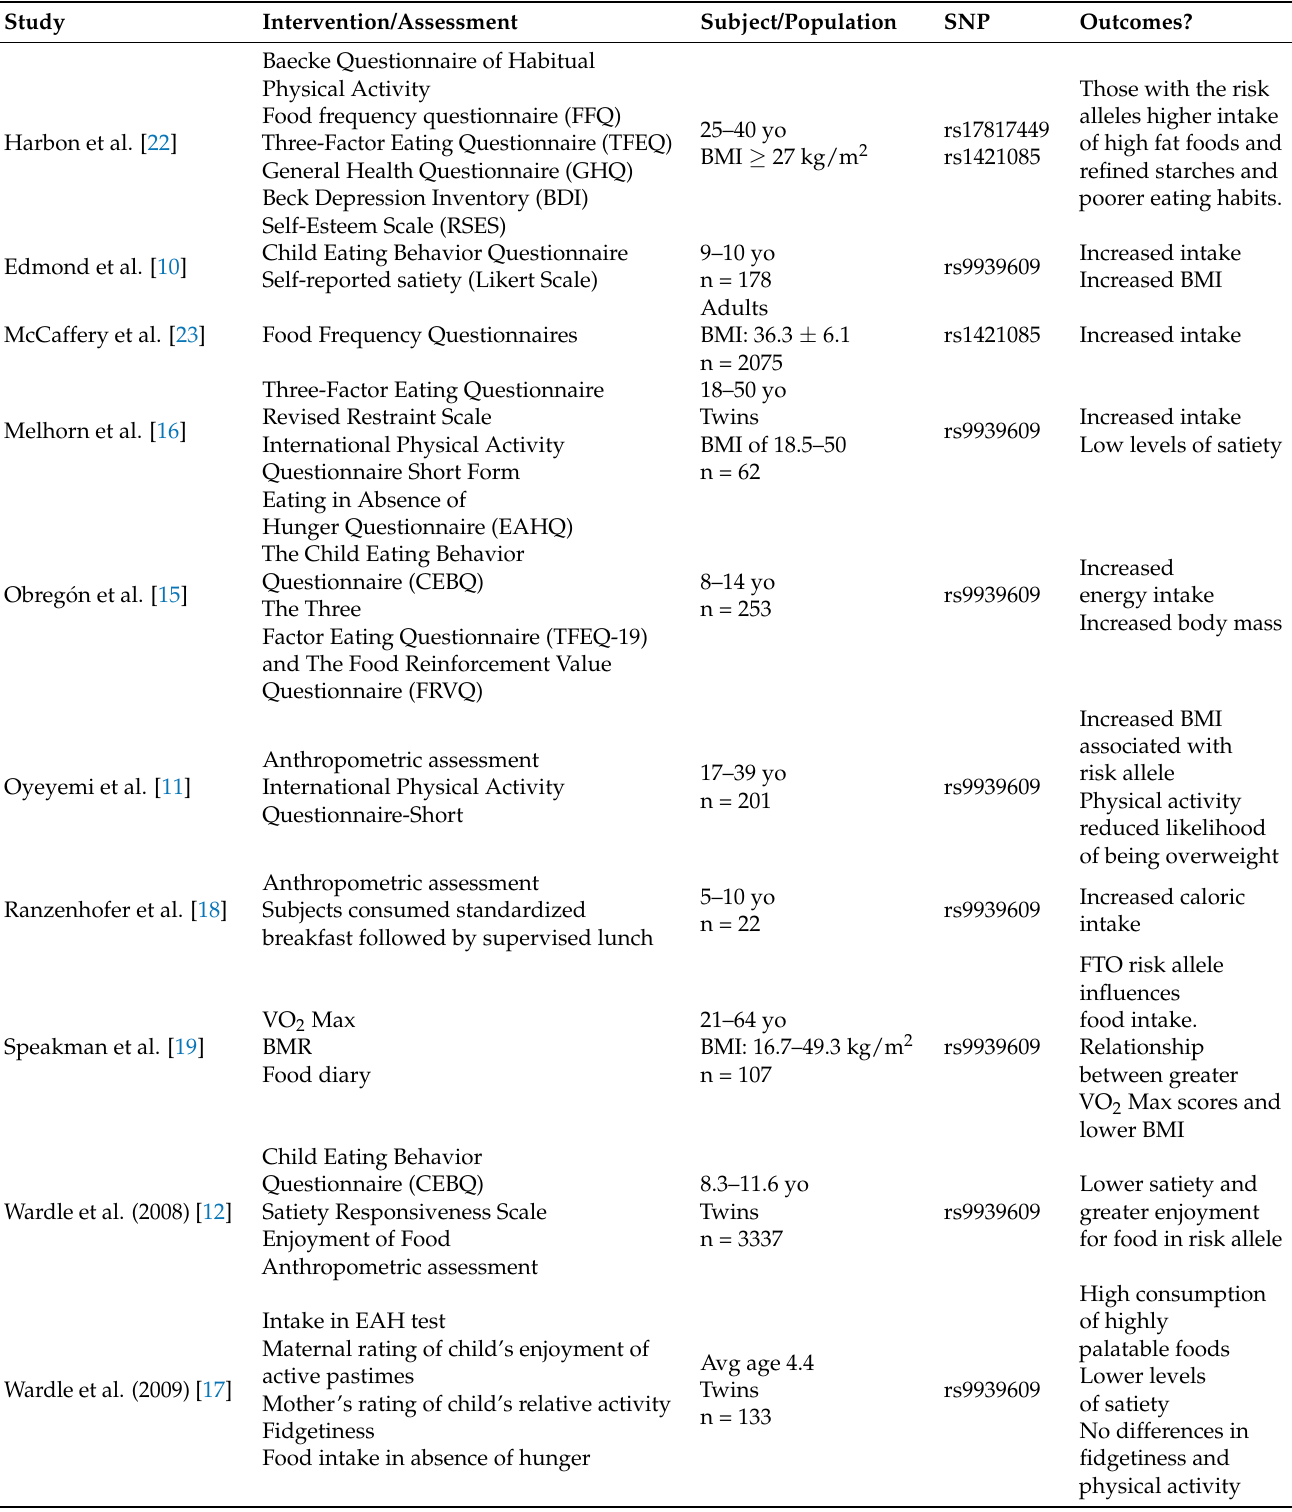
Table 2. Summary of Studies assessing Dietary